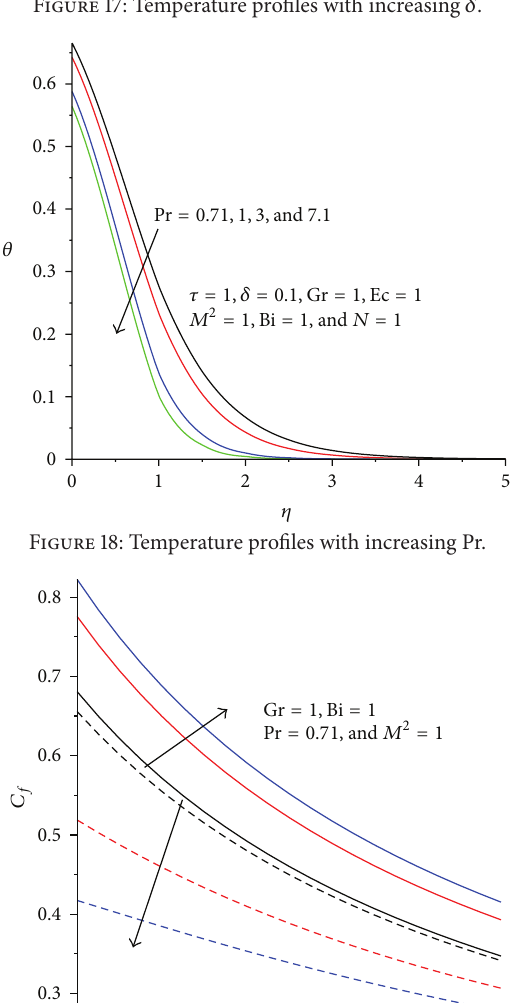
of magnetic field, buoyancy force, and viscous dissipation, leading to a fall in the Nusselt